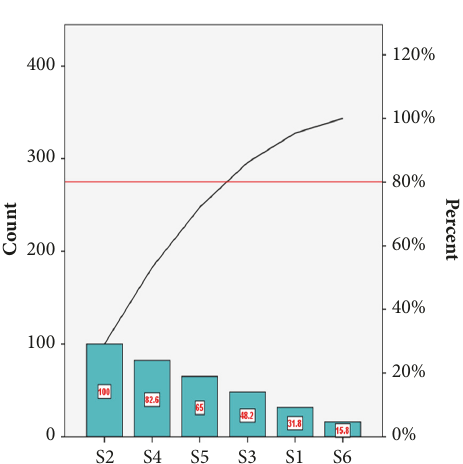
Figure 2: Pareto chart for all the processes.